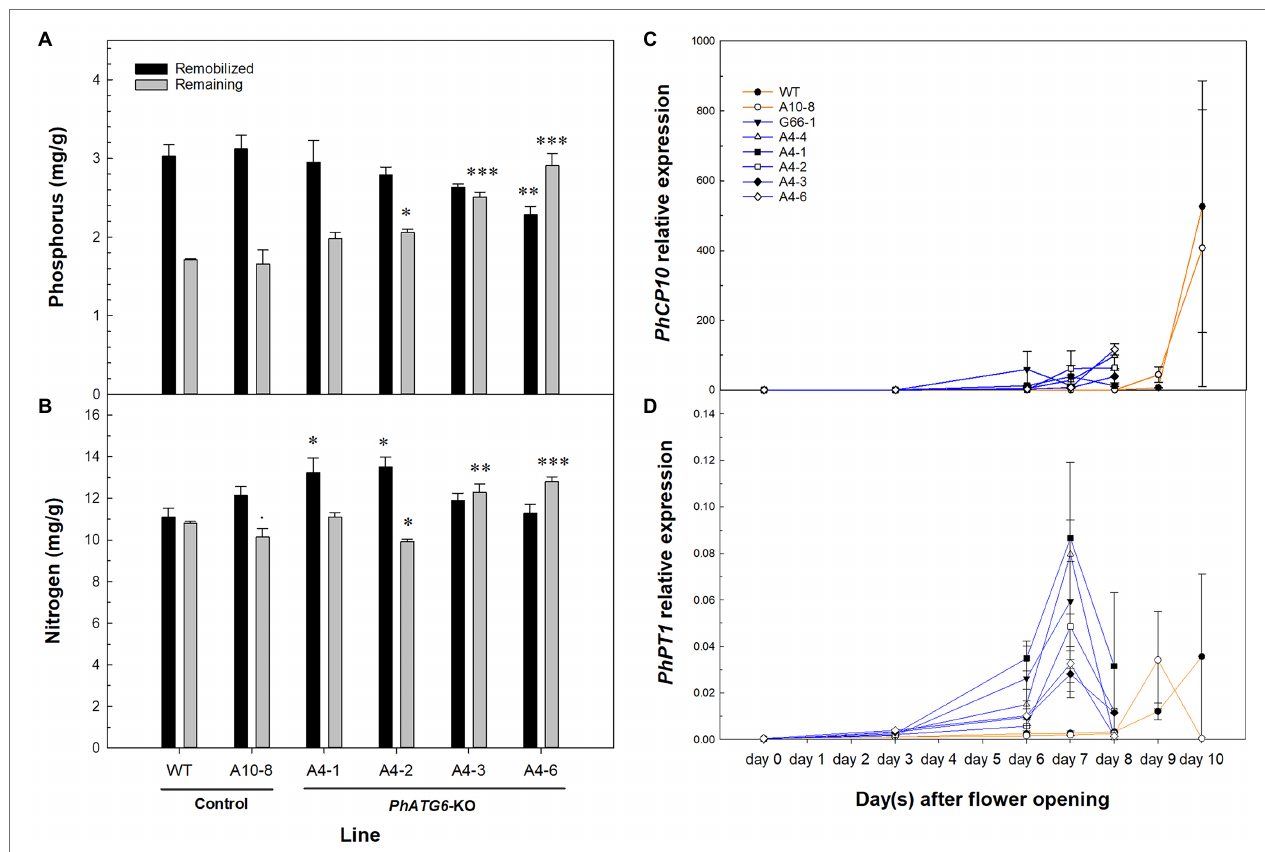
FIGURE 7 | Nutrient mobilization from corollas of the Petunia × hybrida ‘Mitchell Diploid’ wild-type plant (WT), non-mutated regenerated line A10-8, and PhATG6 - KO lines. Concentration of phosphorus (P) (A) and nitrogen (N) (B) that was remobilized (black) and remaining (grey) in the senescing corollas ( n = 3). Relative expression of senescence-associated Cysteine Protease 10 ( PhCP10 ) (C) and Phosphate Transporter 1 ( PhPT1 ) (D) from corolla opening to senescence ( n = 2). The remaining P and N is the concentration in senescing corollas. Remobilized N and P were calculated by subtracting the concentration of individual nutrients in the senescing corollas from the concentration in the non-senescing corollas. Orange lines represent the results of controls (WT and line A10-8), and blue lines represent the results of the PhATG6 -KO lines. The relative expression was calculated based on the expression of reference genes PhActin and PhSAND . Data represent the means of the measurements ± standard error. Bars represent the means of the measurements ± standard error, and bars with stars indicate a significant difference compared to the WT: “***” p ≤ 0.001, “**” p ≤ 0.01, “*” p ≤ 0.05, “.” p ≤